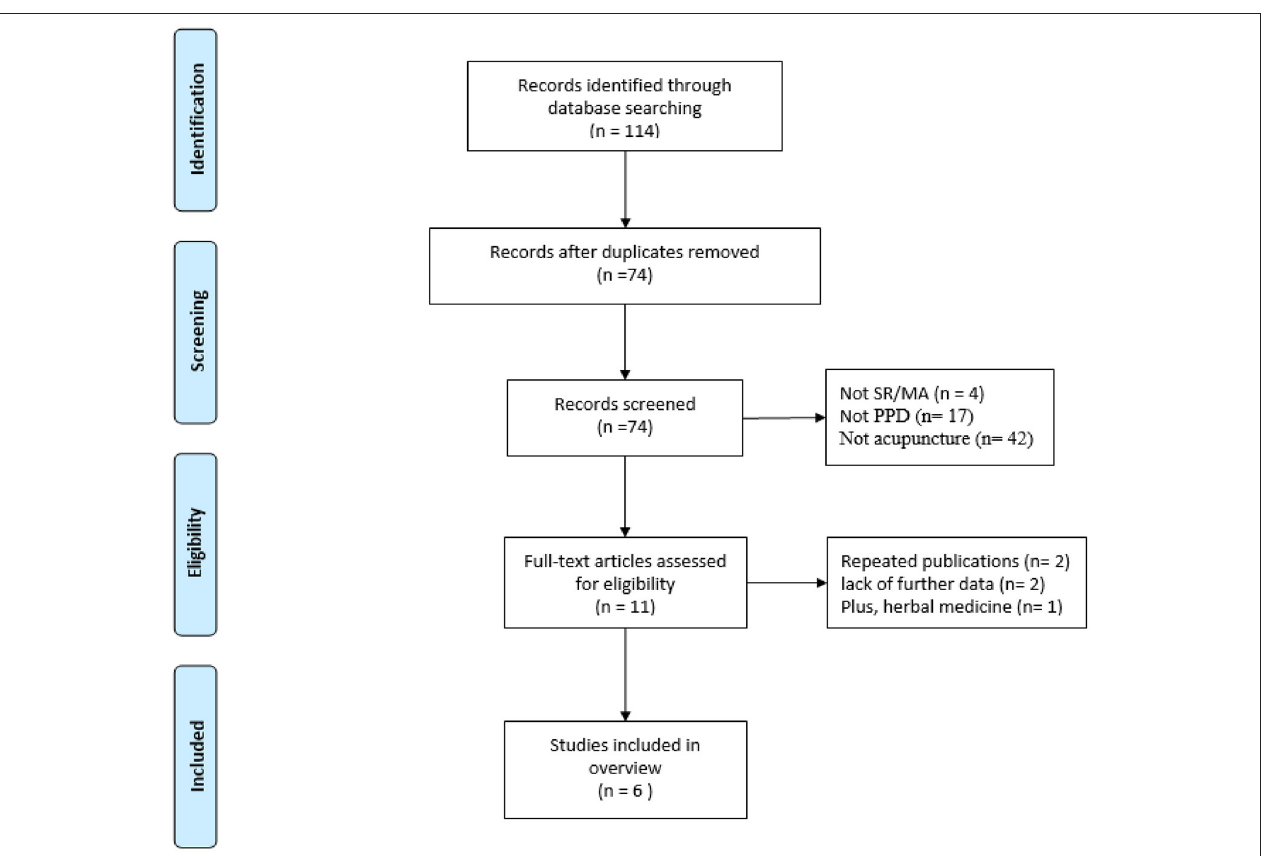
FIGURE 1 | Flow diagram of the literature